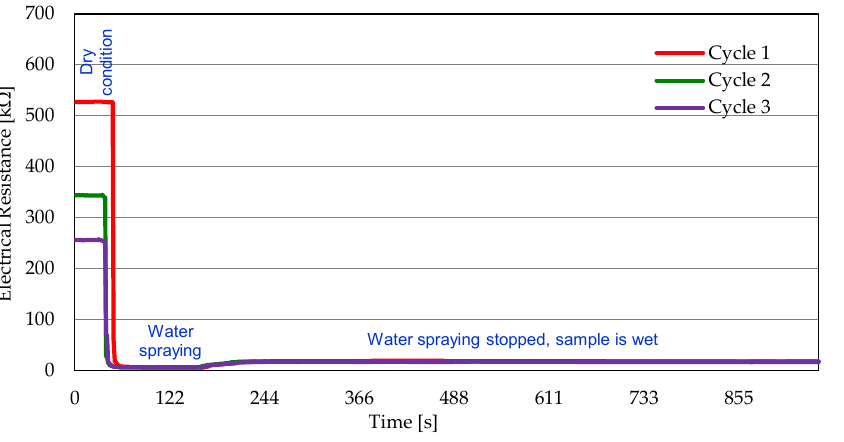
Figure 8. Electrical resistance of the W14 fastening system as a function of time for all three meas- ured cycles.